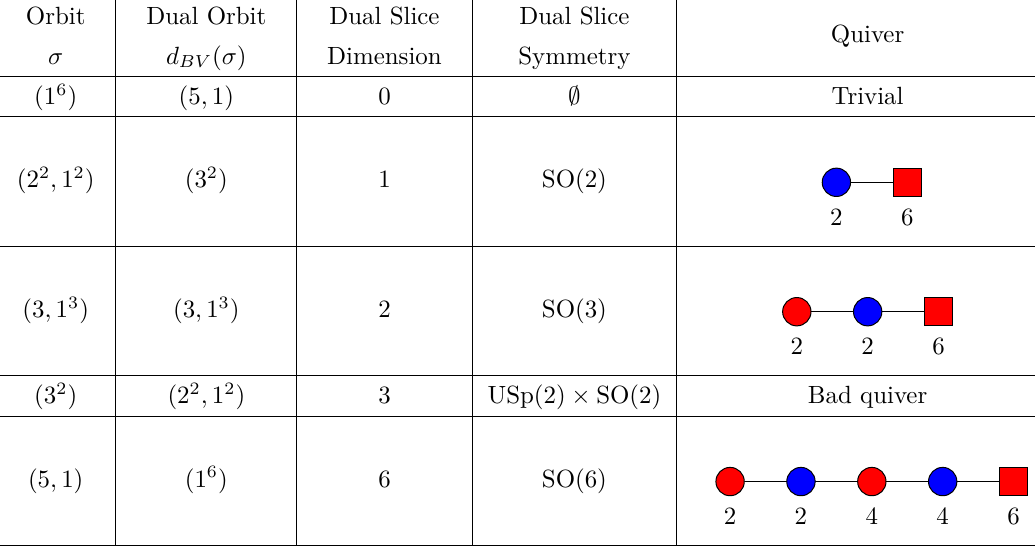
T (SO(6)) linear quivers. These are used in untwisted D 3 fixtures. The quivers T (SO(6)) have non-diverging monopole formula; the bad quiver with zero conformal dimen- d BV ( σ ) sion is not shown. The partitions identify special orbits of SO(6)